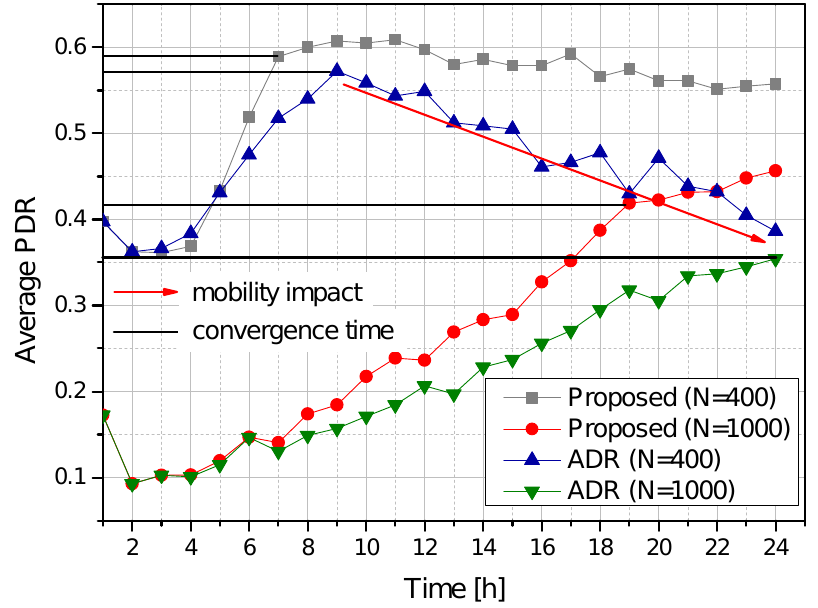
Figure 4. Convergence time and PDR of the Proposed ADR and ADR. However, in the proposed ADR for the N = 400 and N = 1000, the convergence time is 9 and 19 h, respectively. The primary reason behind this low convergence time is that the proposed ADR at the NS side manages to smooth the signal strength and identify the best possible configuration containing both SF and TP. In addition, the proposed ADR considers the P rx value, which helps to identify a suitable SF for the ED, thus decreasing the chances of packet loss arriving under the SF sensitivity